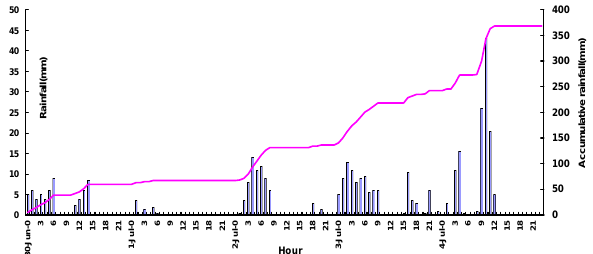
Fig. 21. Distribution of hourly and cumulative precipitation between June 30 and July 4, 2010 in Qingping Town.